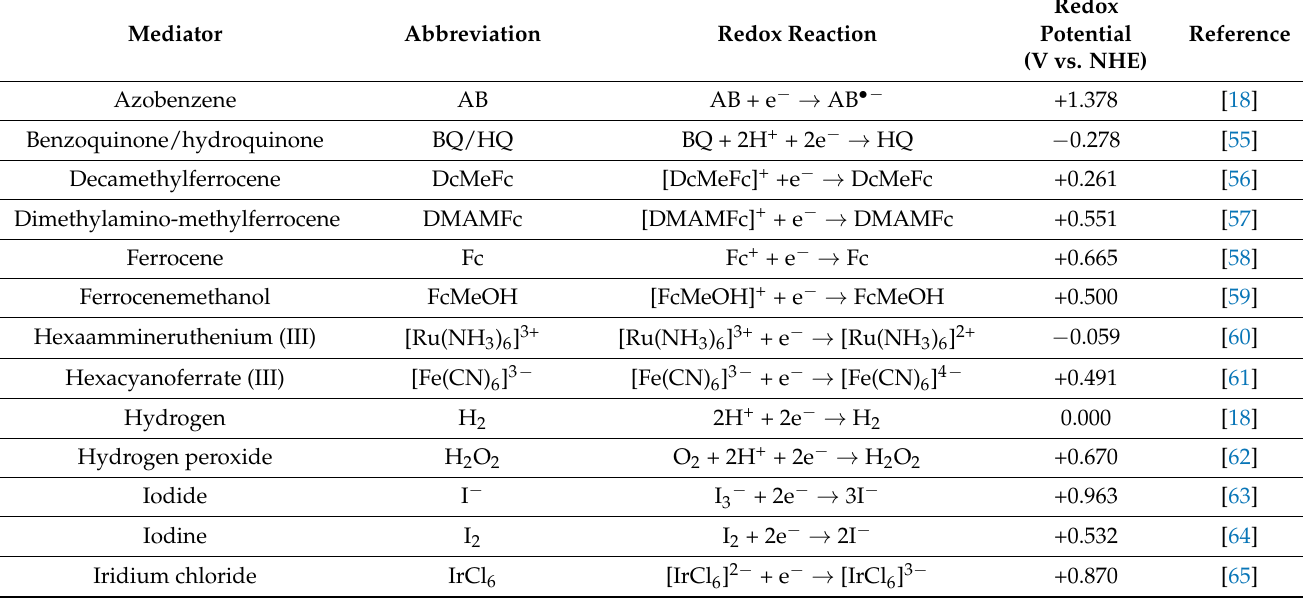
Table 2. Redox mediators used in the amperometric SECM characterization of thin surface layers and coatings on